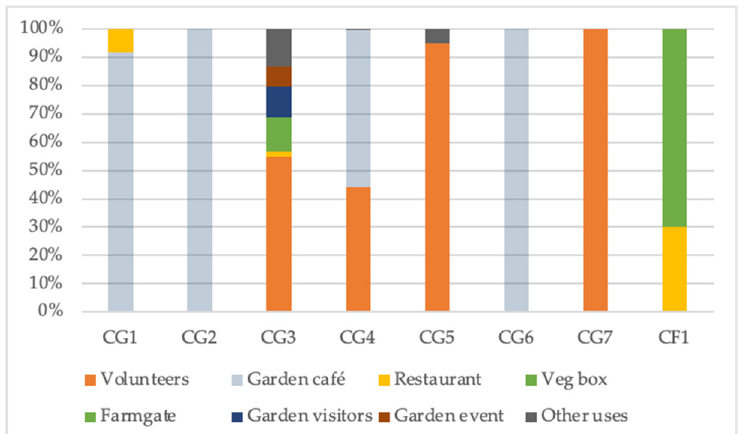
Figure 1. Crop productivity of 7 community gardens and 1 city farm measured in kg/m 2 of cultivated surface area.